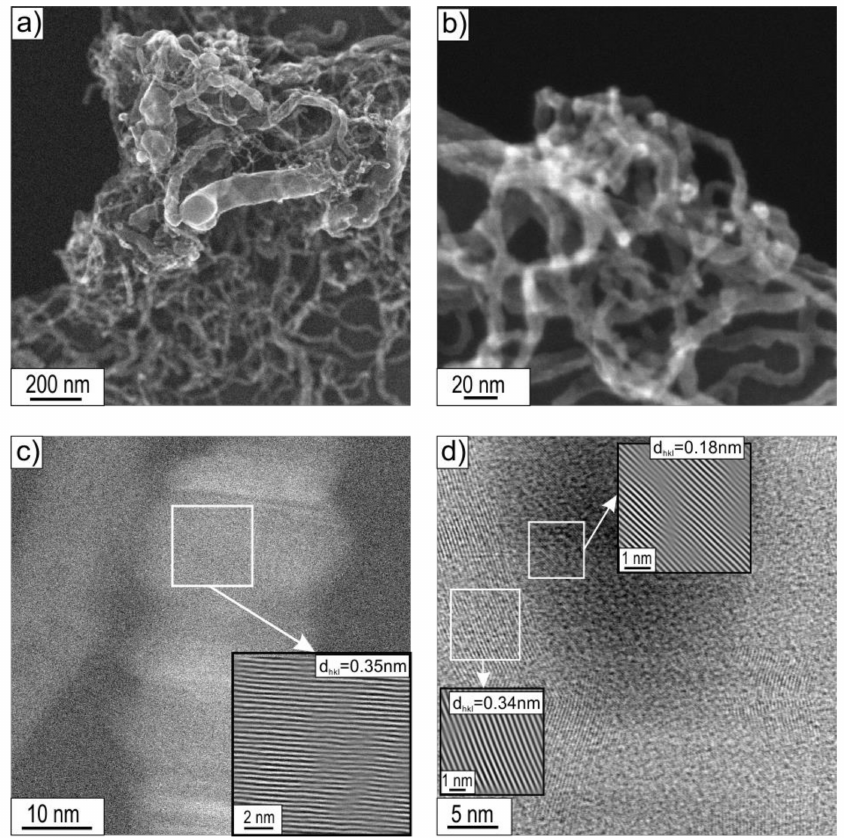
Figure 10. STEM morphology of deposit formed on the Ni 3 Al catalyst surface layer after decomposi- tion of ethanol with 1.1 vol.% water vapour (mixture #3) at 500 ◦ C: ( a,b ) general view and area of: ( c ) platelet carbon nanofibre ( d ) multiwalled carbon nanotube ended by Ni particle ( a , b —SE mode; c —BF mode with HRTEM of selected area; d —BF mode with the enlarged areas performed using